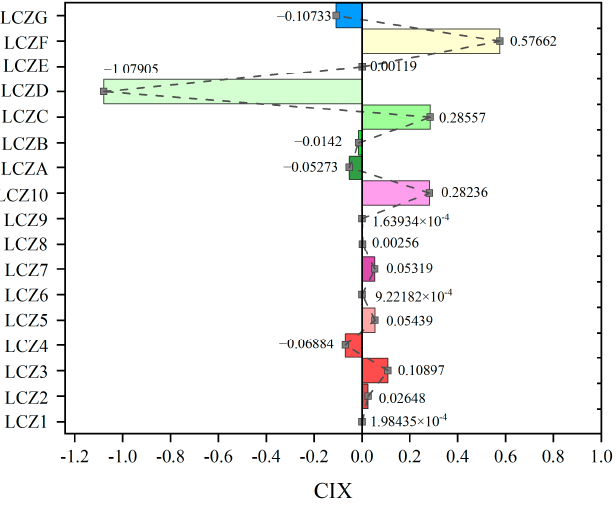
Figure 9. Comparison of LCZ increase/decrease temperature contribution.